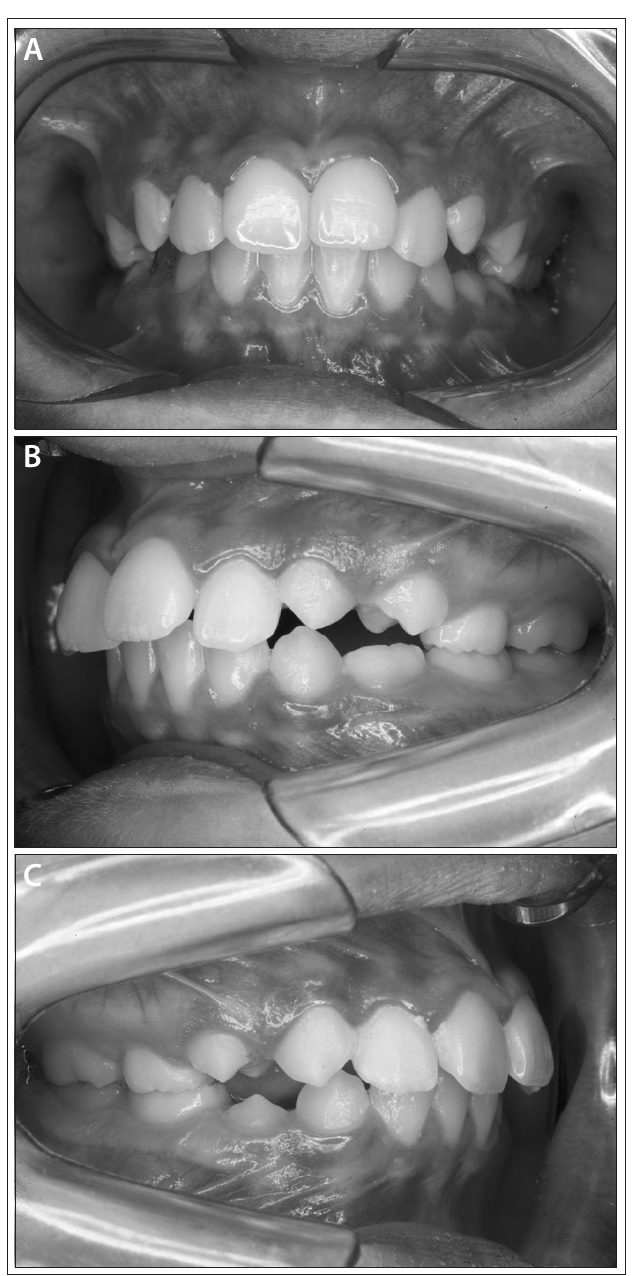
Figure 1. ( A ) Intraoral frontal view before treatment; ( B ) intraoral left side before treatment; ( C ) intraoral right side before